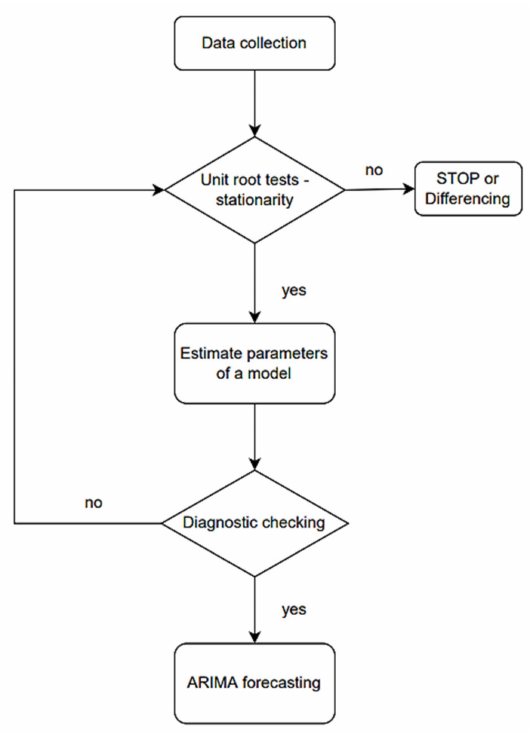
Figure 2. Flowchart of ARIMA modeling and forecasting